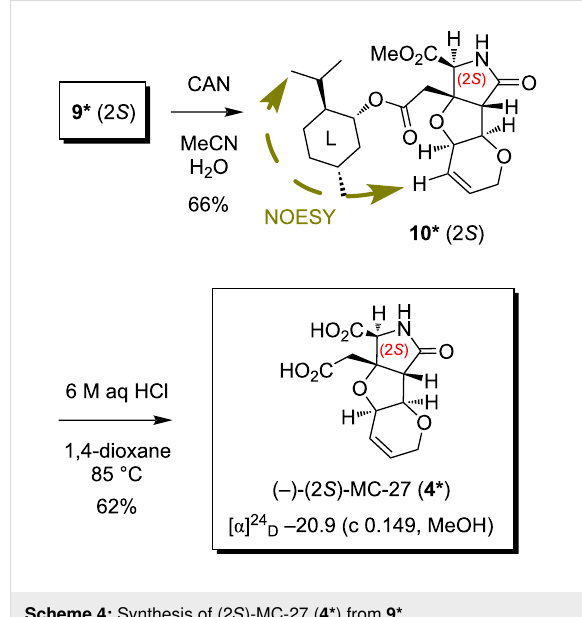
On the other hand, the N -PMB amide 9* (2 S , t R 7.0 min